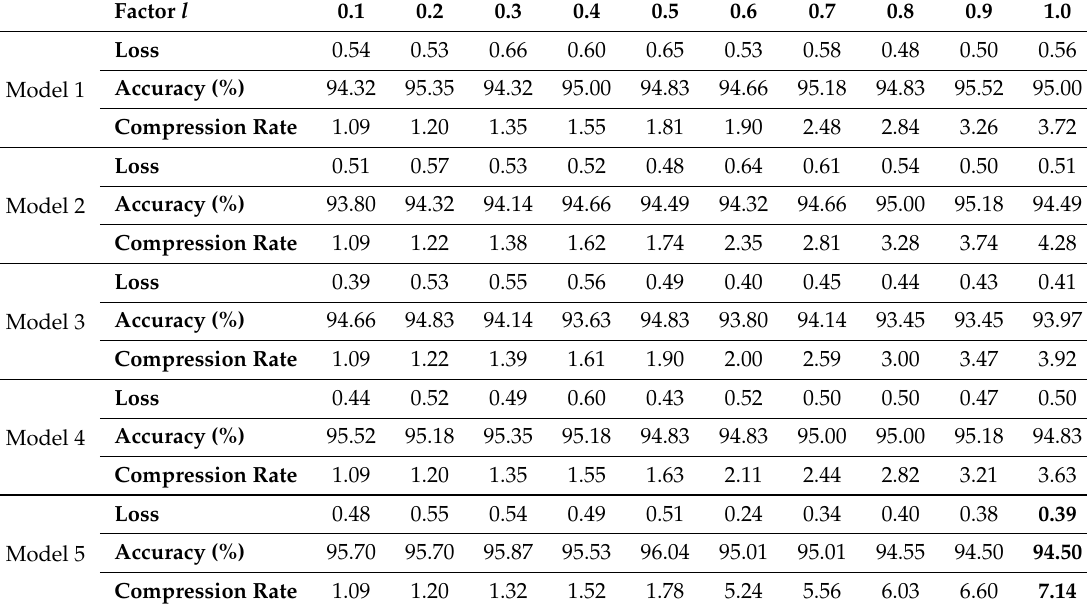
Table 5. Evaluation of the performance for the developed architectures with the method of pruning scalar weights with retraining. Factor l corresponds to the portion of standard deviation used to determine the threshold for